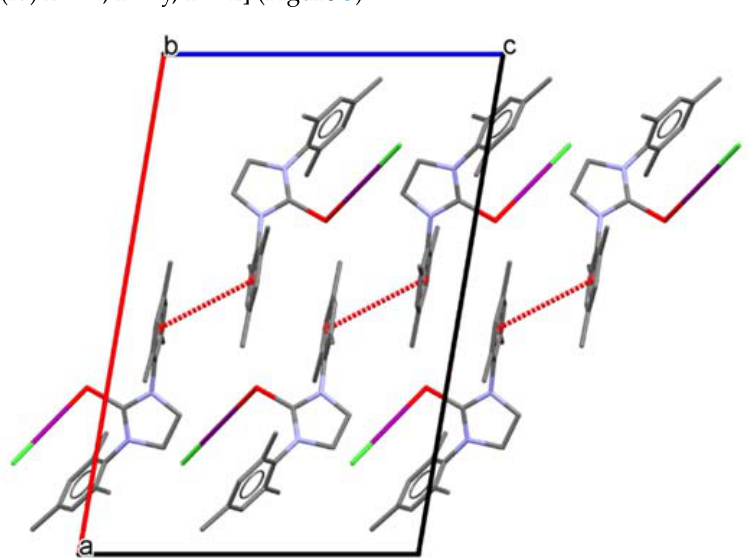
Figure 5. Packing in the crystal structure of Compound 6 viewed down the b-axis with the shortest π − π interactions (4.396(3) Å) indicated, i.e., between mesityl ring centroids and their symmetry-equivalents. Hydrogen atoms and solvent molecules are omitted for clarity.